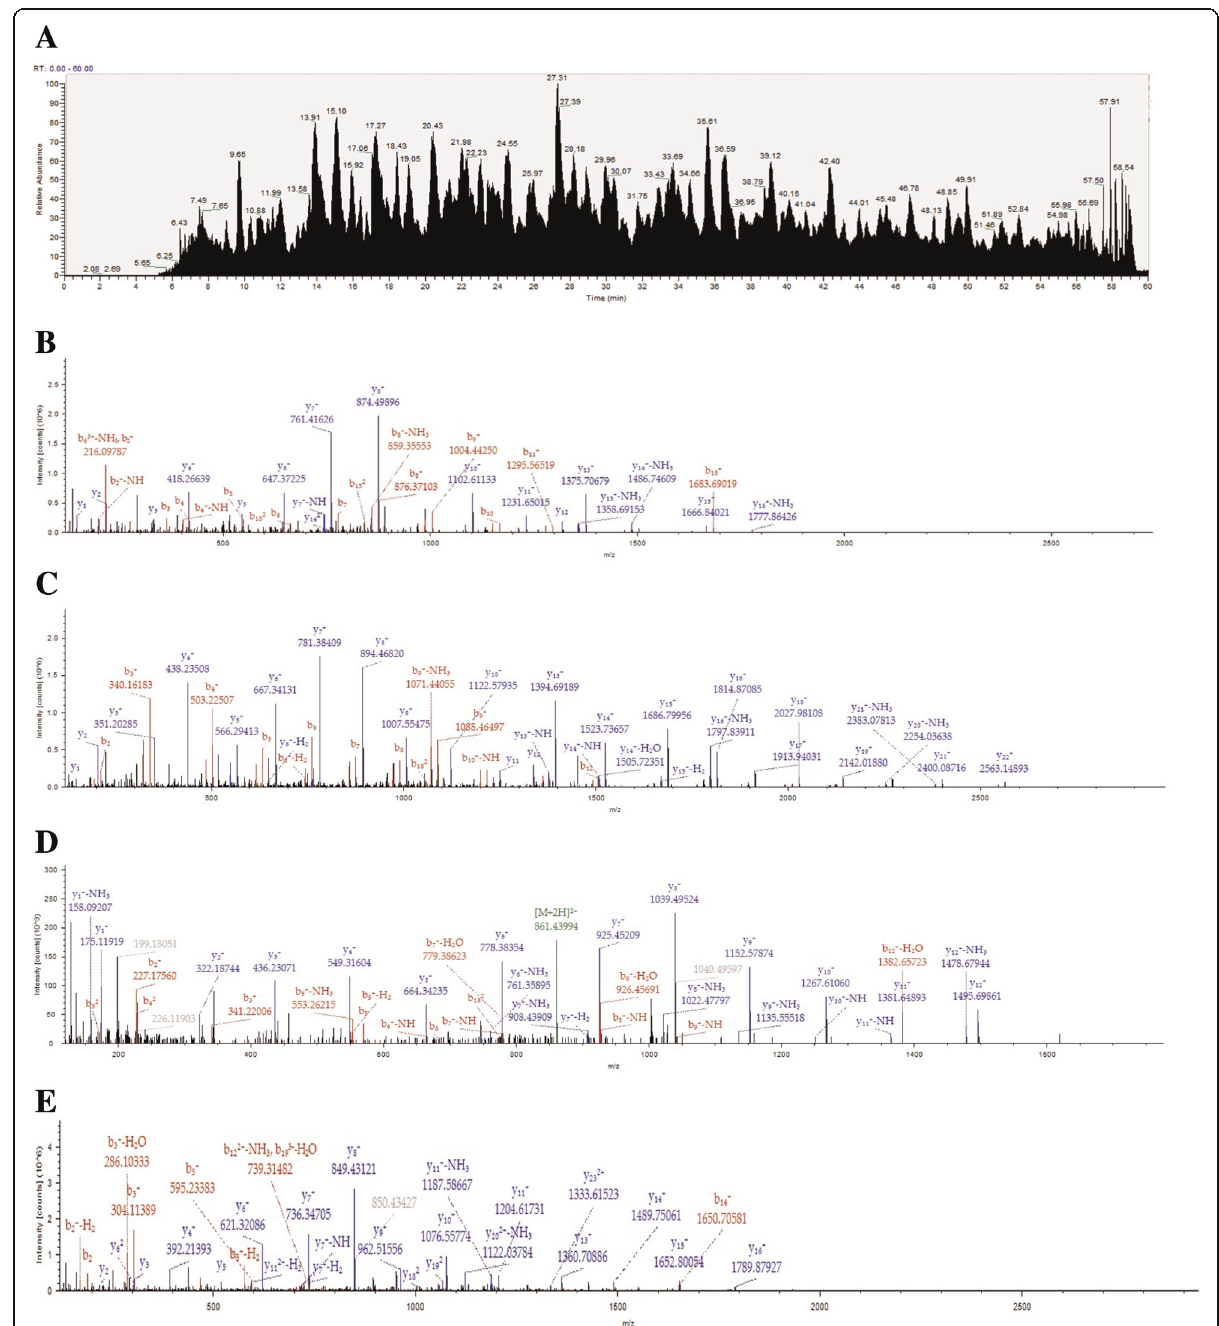
Fig. 4 Identification and quantitative analysis of bioactive protein fraction using Label-free protein quantification method. a Total ions chromatograph of proteins present in Fraction 2. b Partial MS/MS fragmentation sequencing spectrum of MRJP2 (SQFGENNVQYQGSEDILNTQSLAK). c Partial